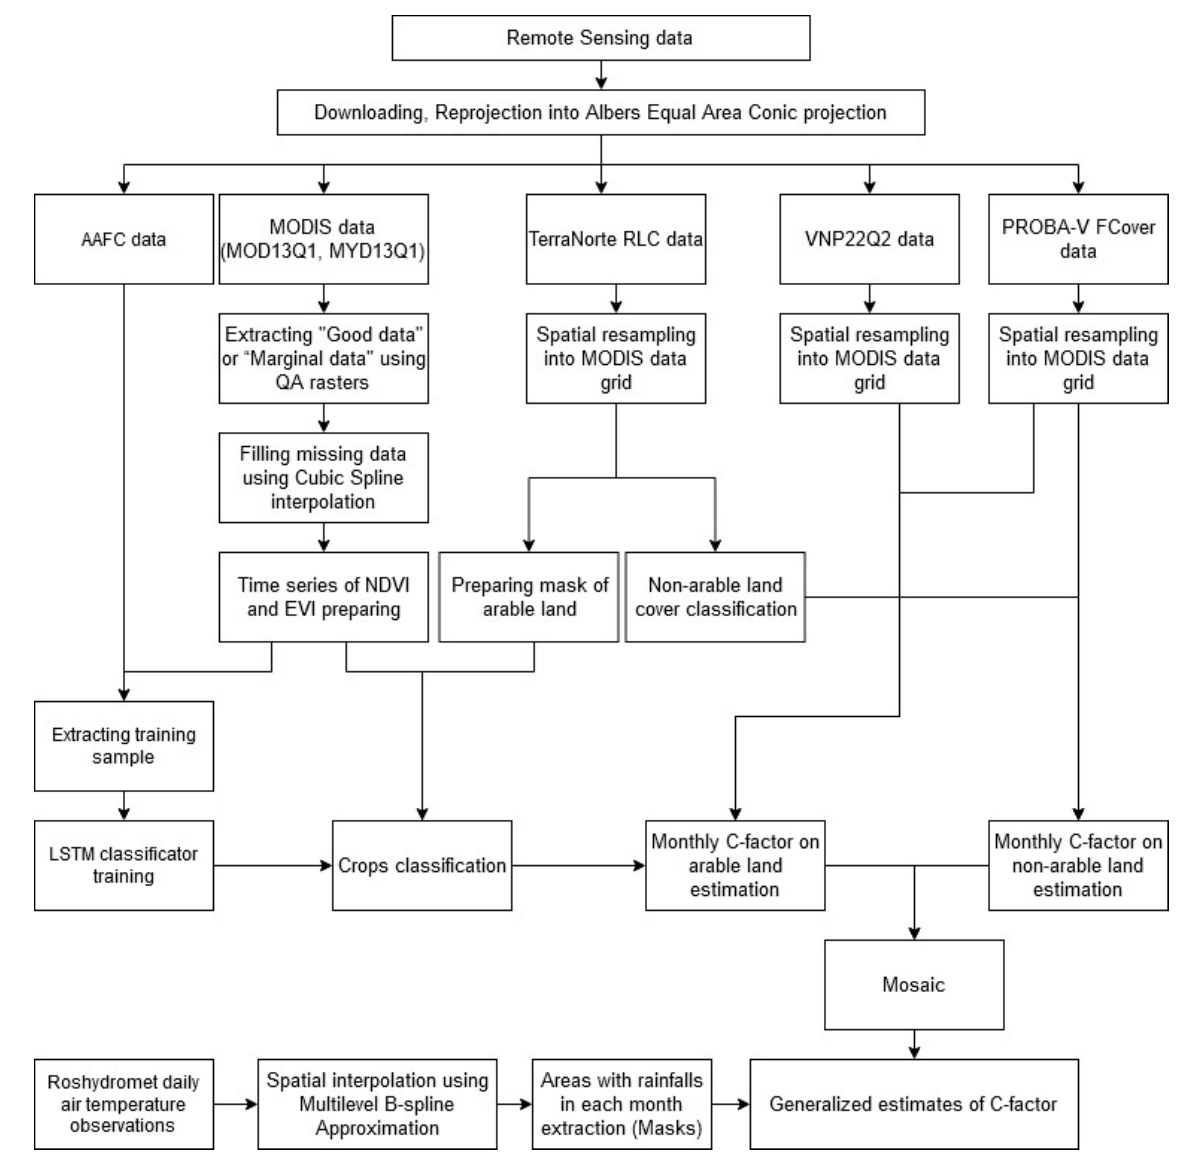
Figure 1. The general scheme of the procedure for assessing the C-factor.